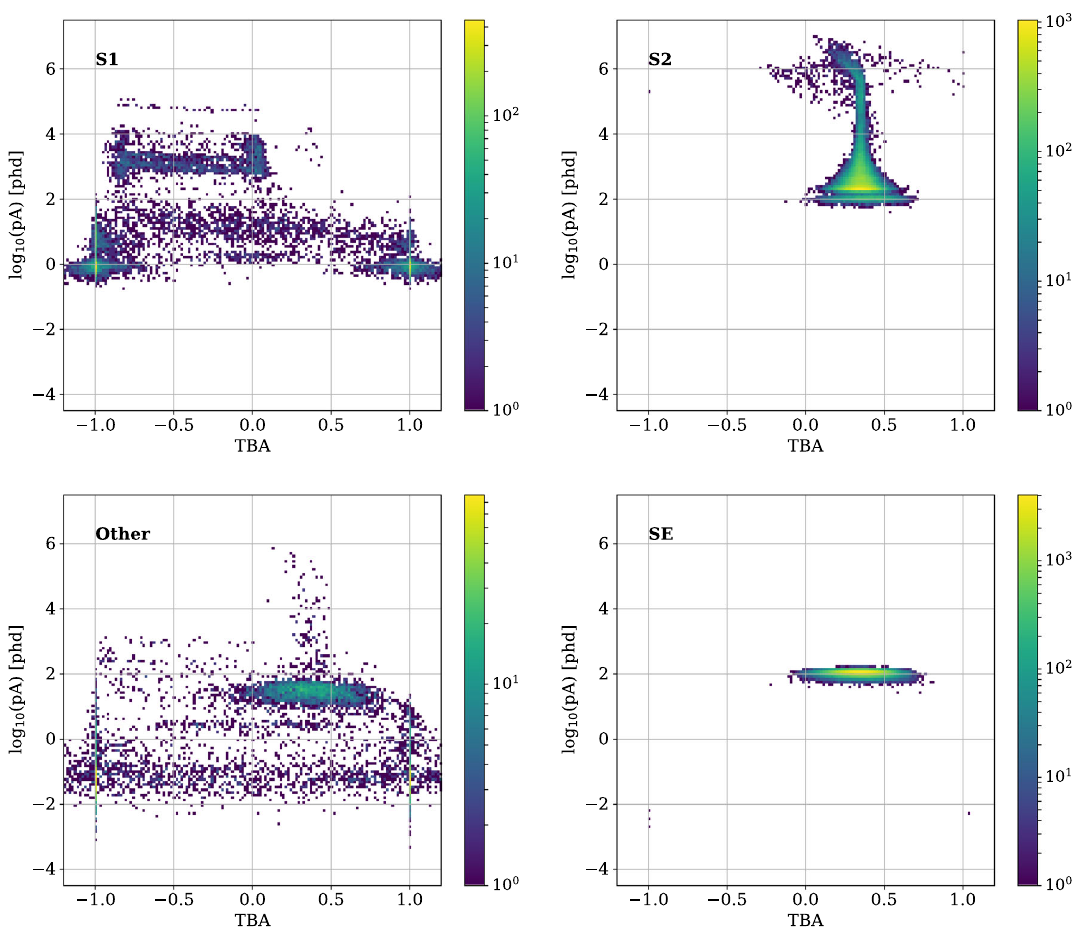
Fig. 8 Distribution of the pulse populations in the marginal distribu- tion TBA vs pA after being processed by the TriNet Classifier trained withtheGMMresults,andconvertedtocategoricalclassifications.Top-